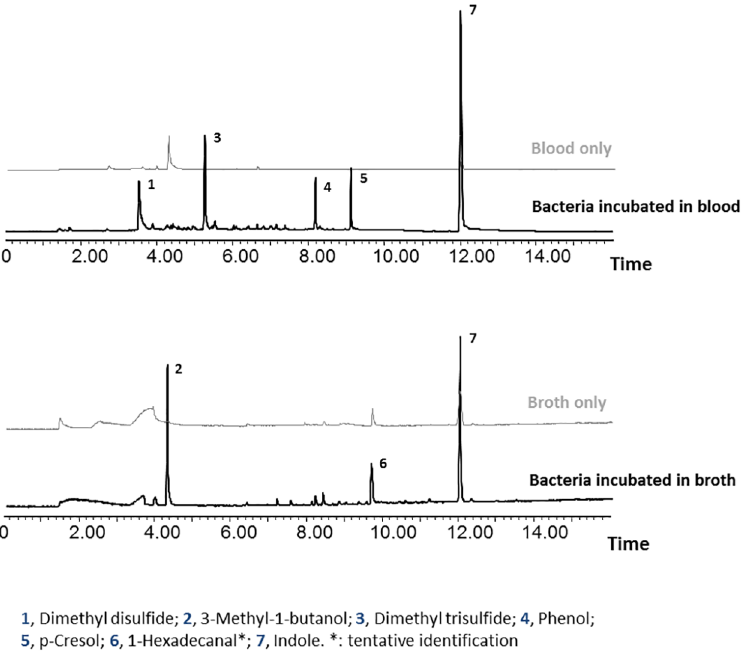
Fig 1. Solid phase micro-extraction absorptions of volatiles releasedfrom bacteria incubated with blood and broth for 72 hours, as well as their controls with medium only (8 hours